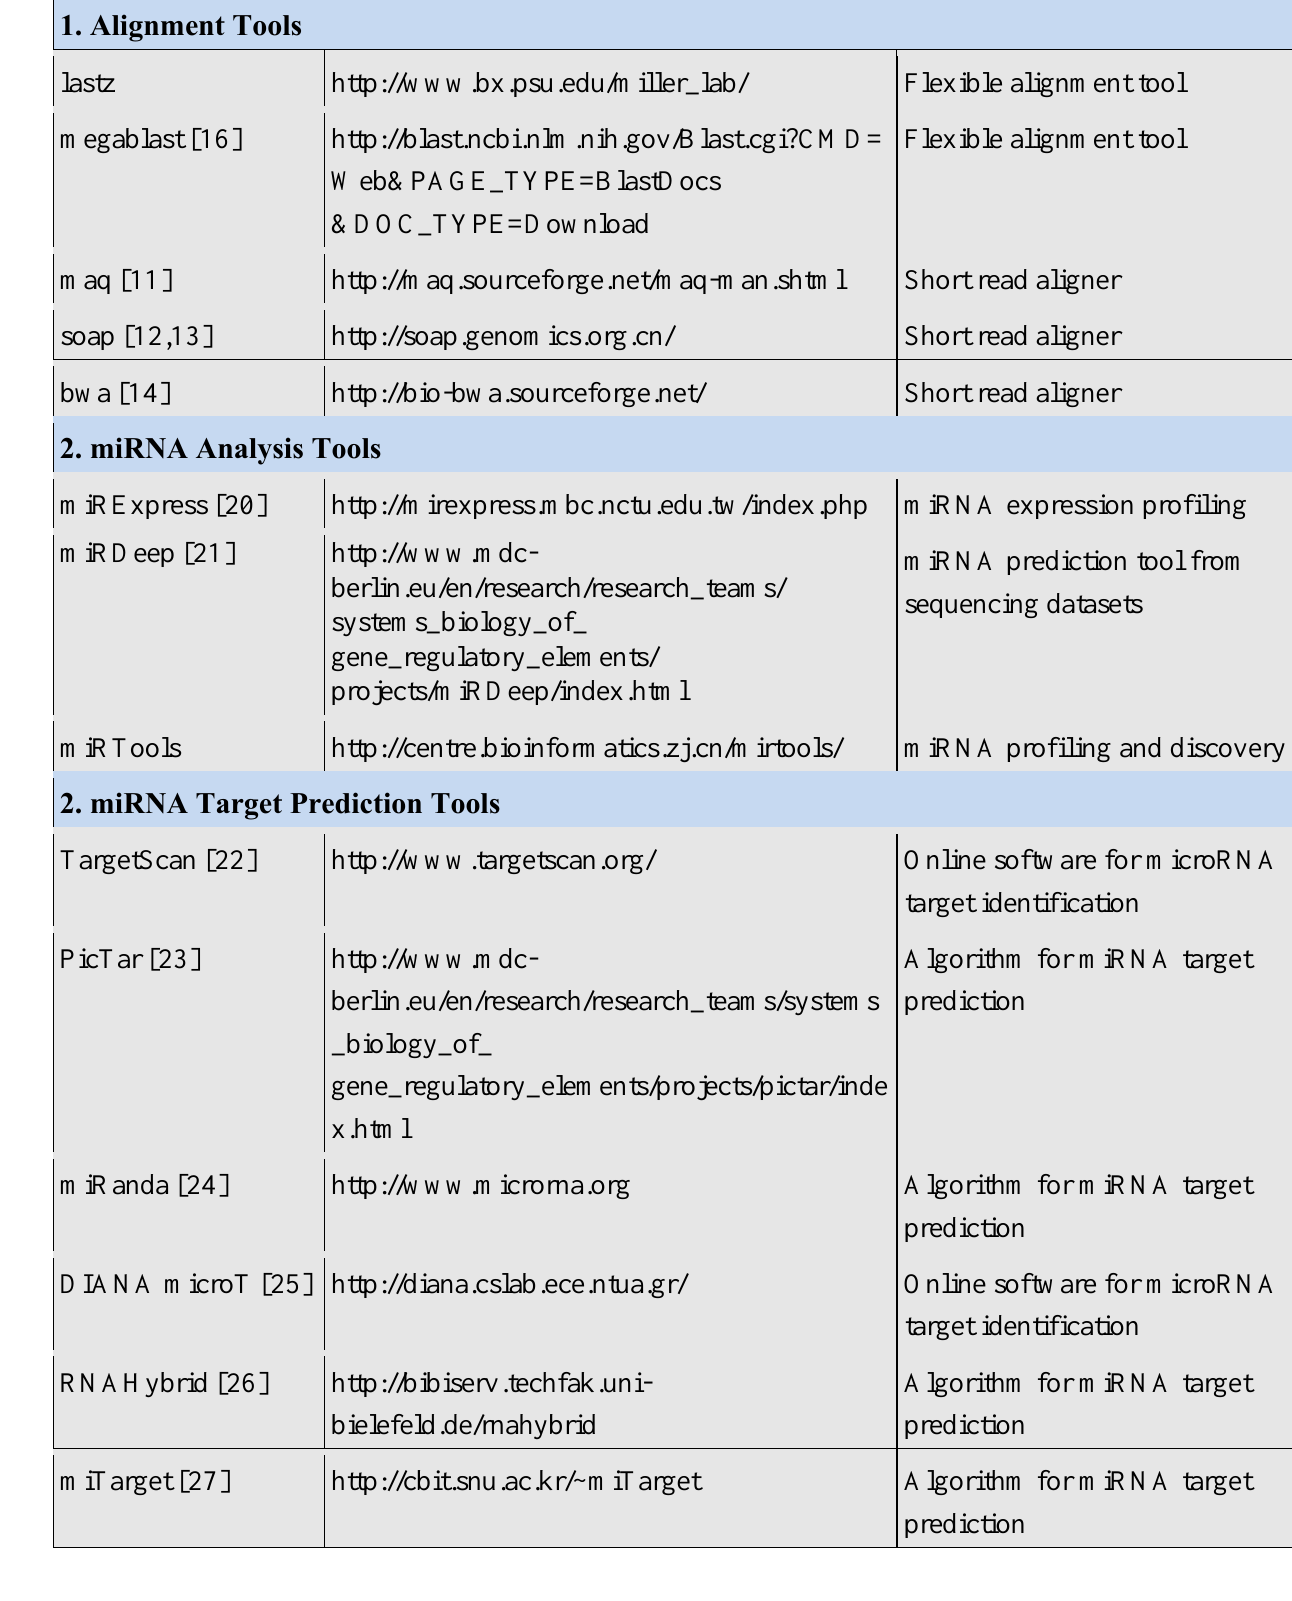
Table 1. miRNA Online Resources and